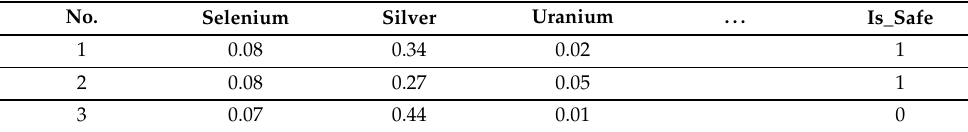
Table 3. Sample records from water quality dataset.